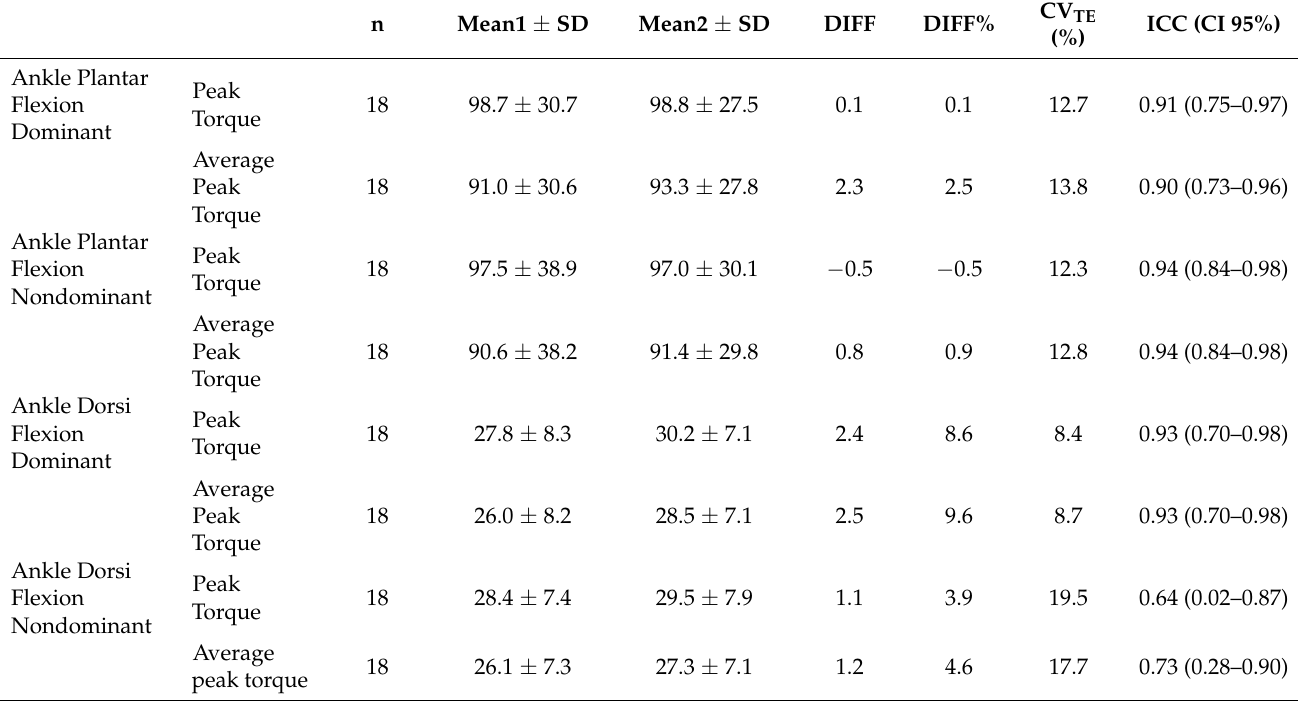
Table 1. Ankle plantar and dorsi